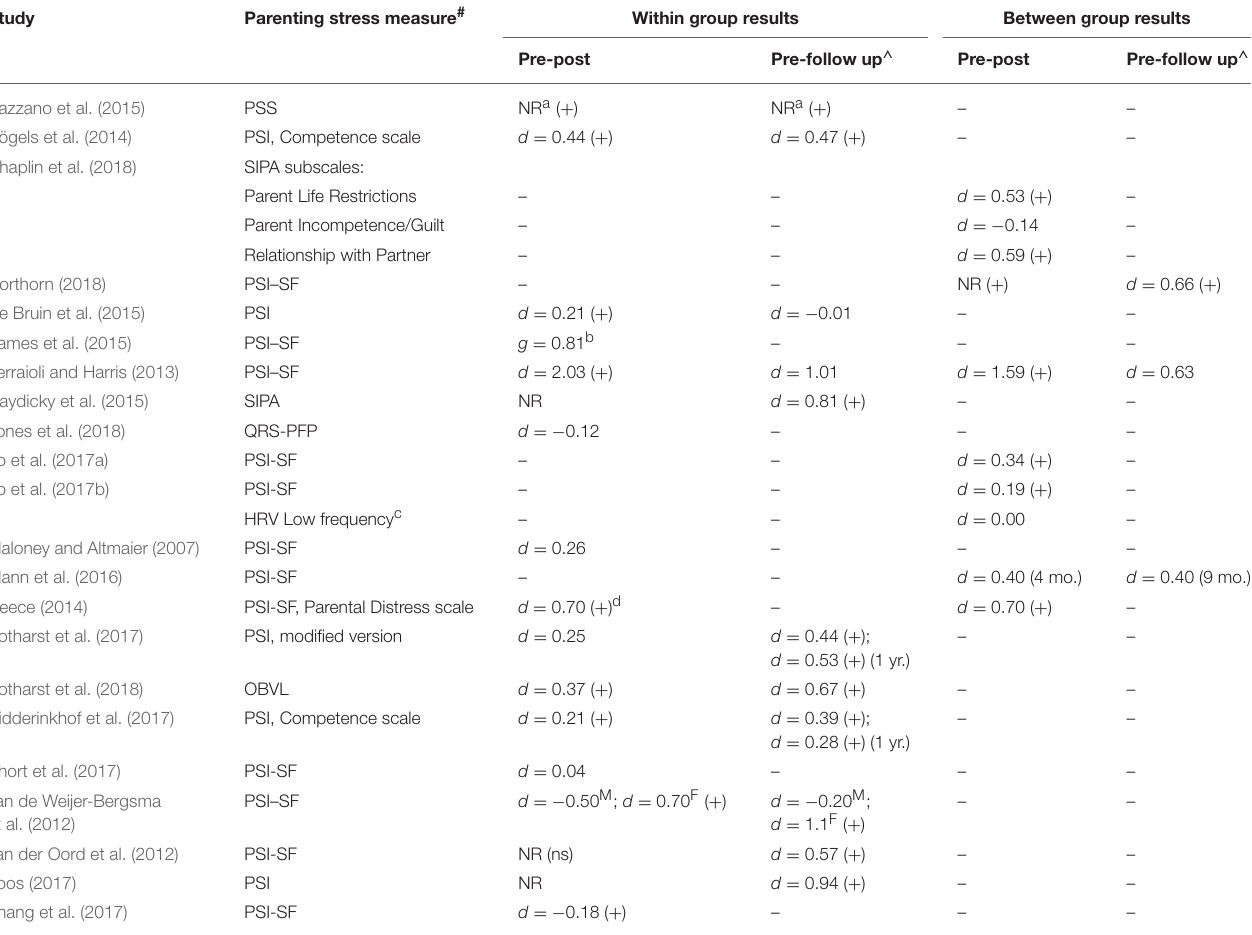
TABLE 2 | Reported results of mindfulness intervention, for parenting